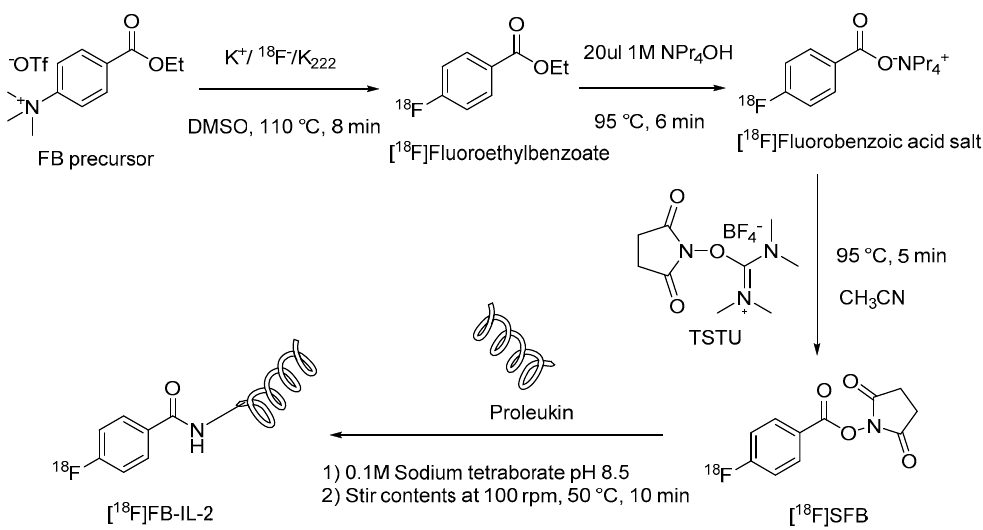
Scheme 1. Semi-automated synthesis of [ 18